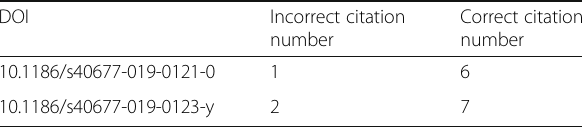
Table 1 Overview of incorrect and correct citation metadata